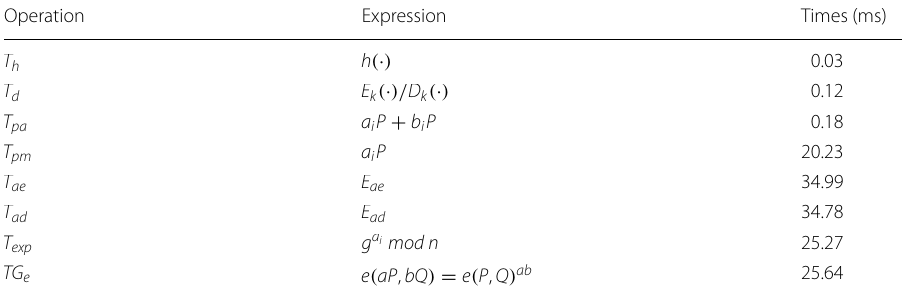
Table 2 Computation time Operation Expression